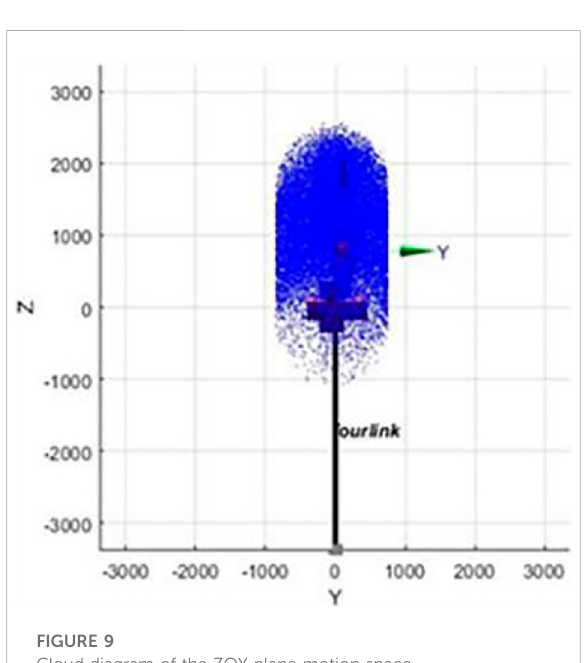
FIGURE 6 Cloud diagram of the manipulator movement space.